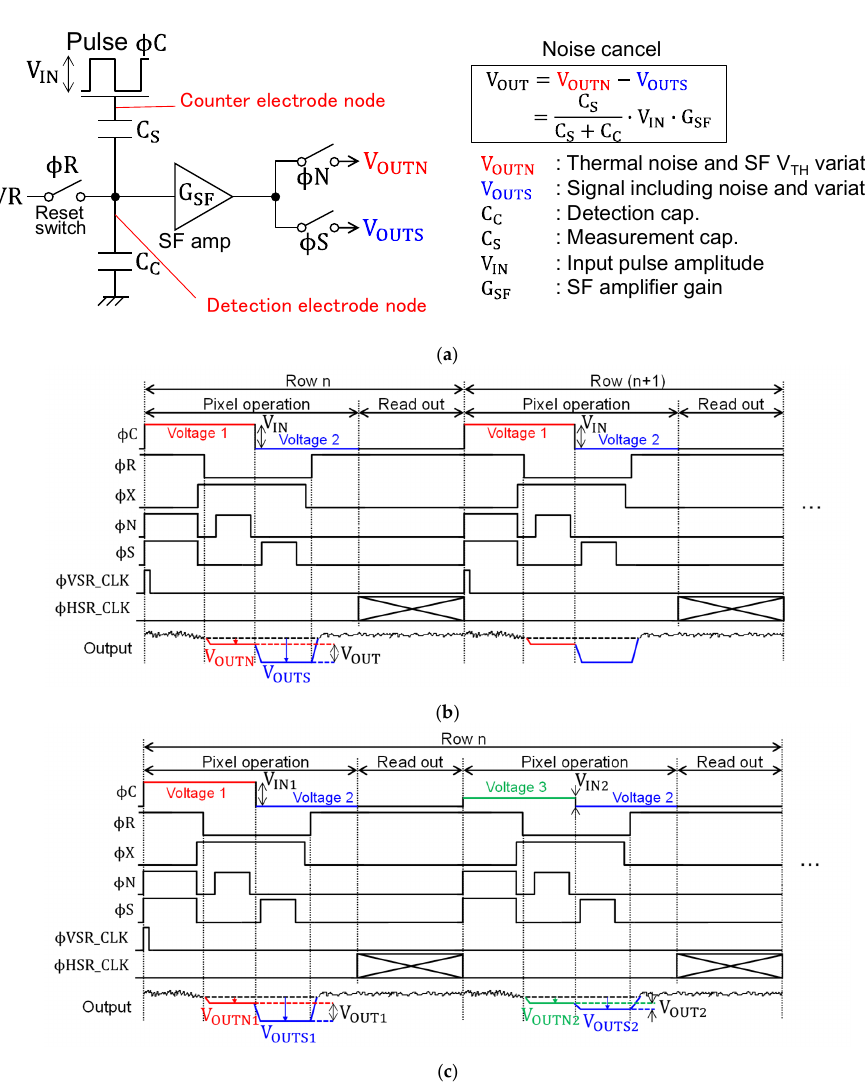
Figure 3. Principle of operation of proximity capacitance image sensor: ( a ) simplified circuit and noise cancelling principle; ( b ) timing diagram of normal mode; ( c ) timing diagram of HDR mode.